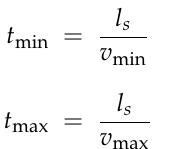
Figure 7. The correlation dependency of the psychophysiological parameter B (BVP VLF % power mean) on the intensity of solar activity.